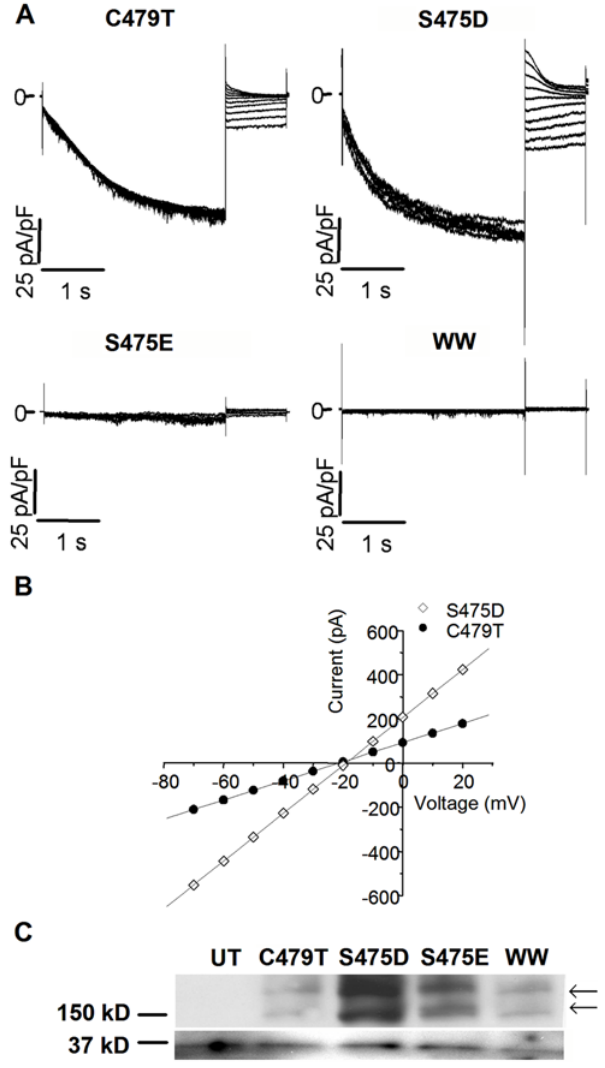
Figure 3. Na + permeability in mutant HCN4 channels. (A) Sample traces of C479T, S475D/C479T, S475E/C479T and F471W/ K472W/C479T HCN4 currents (labeled S475D, S475E and WW for simplicity) recorded in a 5 mM K + /135 mM Na + bath solution, elicited by a 3 s prepulse to 2 130 mV from a holding potential of 0 mV, followed by a 1 s test pulse between + 20 to 2 70 mV ( D V=10 mV). S475E and N WW channels did not express currents. (B) Representative instanta- ) and S475D ( e ) neous I–V relationships from tail currents of C479T ( channels from recordings performed in a 5 mM K + /135 mM Na + bath solution. P X /P K ’s were determined to be 2 17.0 6 1.9 (n=4) and 2 16.2 6 2.0 (n=5) for C479T and S475D channels respectively which were not statistically significant. (C) Western blots performed from whole-cell lysates of untransfected (UT) CHO-K1 cells, or